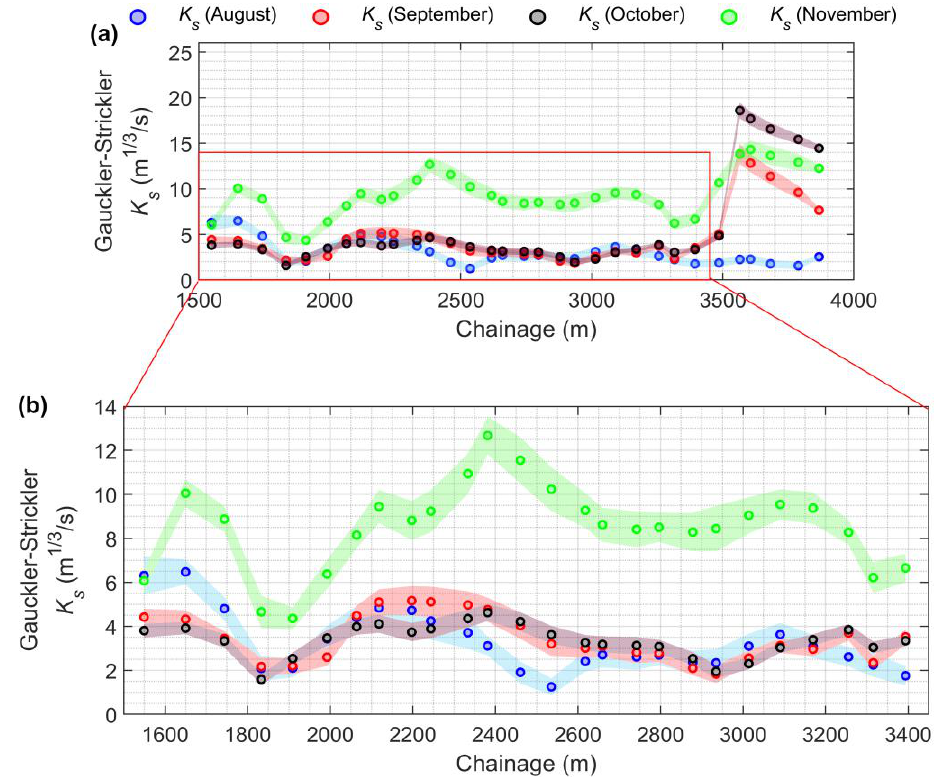
Figure 7. Variation of the Gauckler – Strickler coefficient K s of four months, i.e., August, September, October, and November. The shaded area indicates a 95% confidence interval. ( b ) zoom-in of ( a ) focusing on the first 2-km reach.